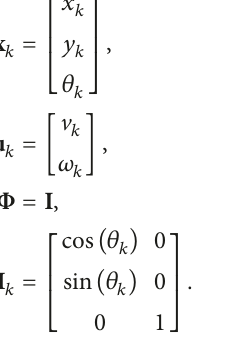
the remaining three motions (i.e., location on the 𝑥 - and 𝑦 - axes and yaw data, which reveals the motion from left to